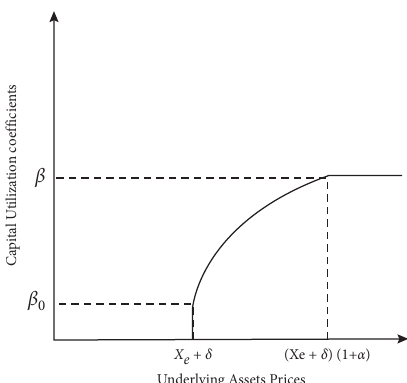
Figure 1: Graphical illustration of the general logarithmic position